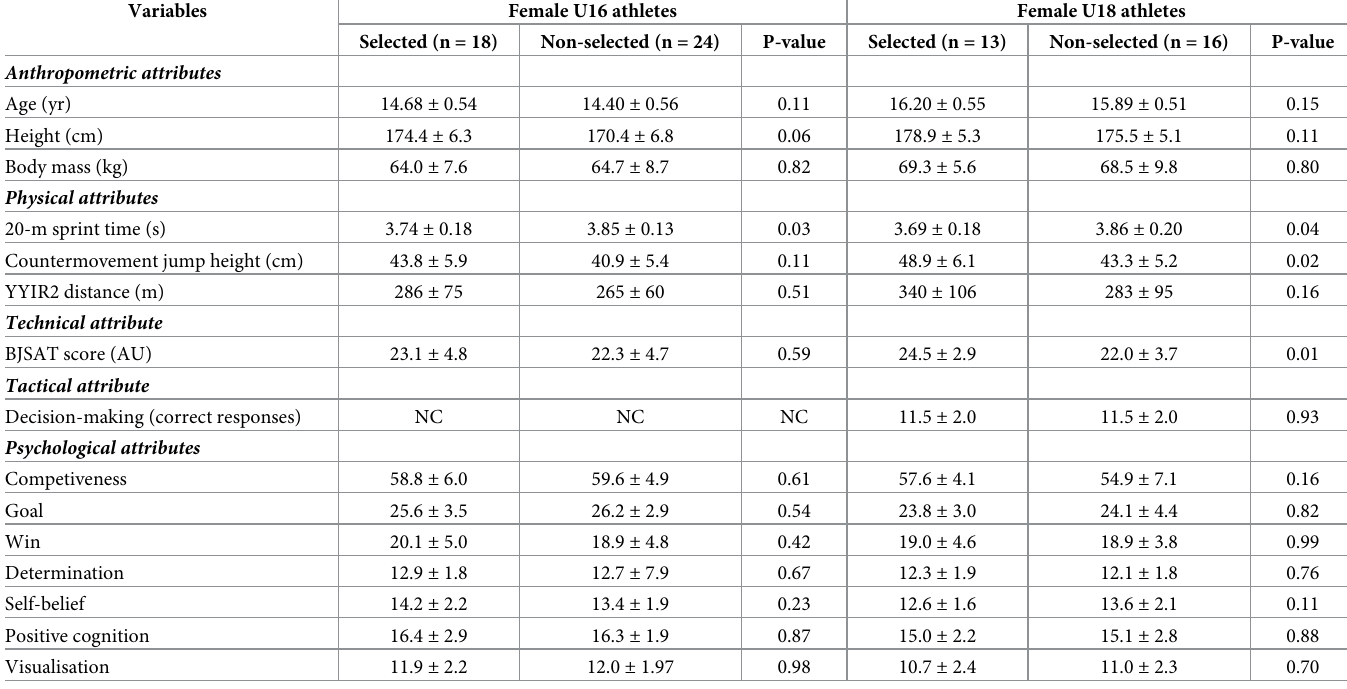
Table 2. Mean ± standard deviation anthropometric, physical, technical, tactical, and psychological attributes with statistical comparisons between selected and non-selected adolescent female basketball athletes according to age group.